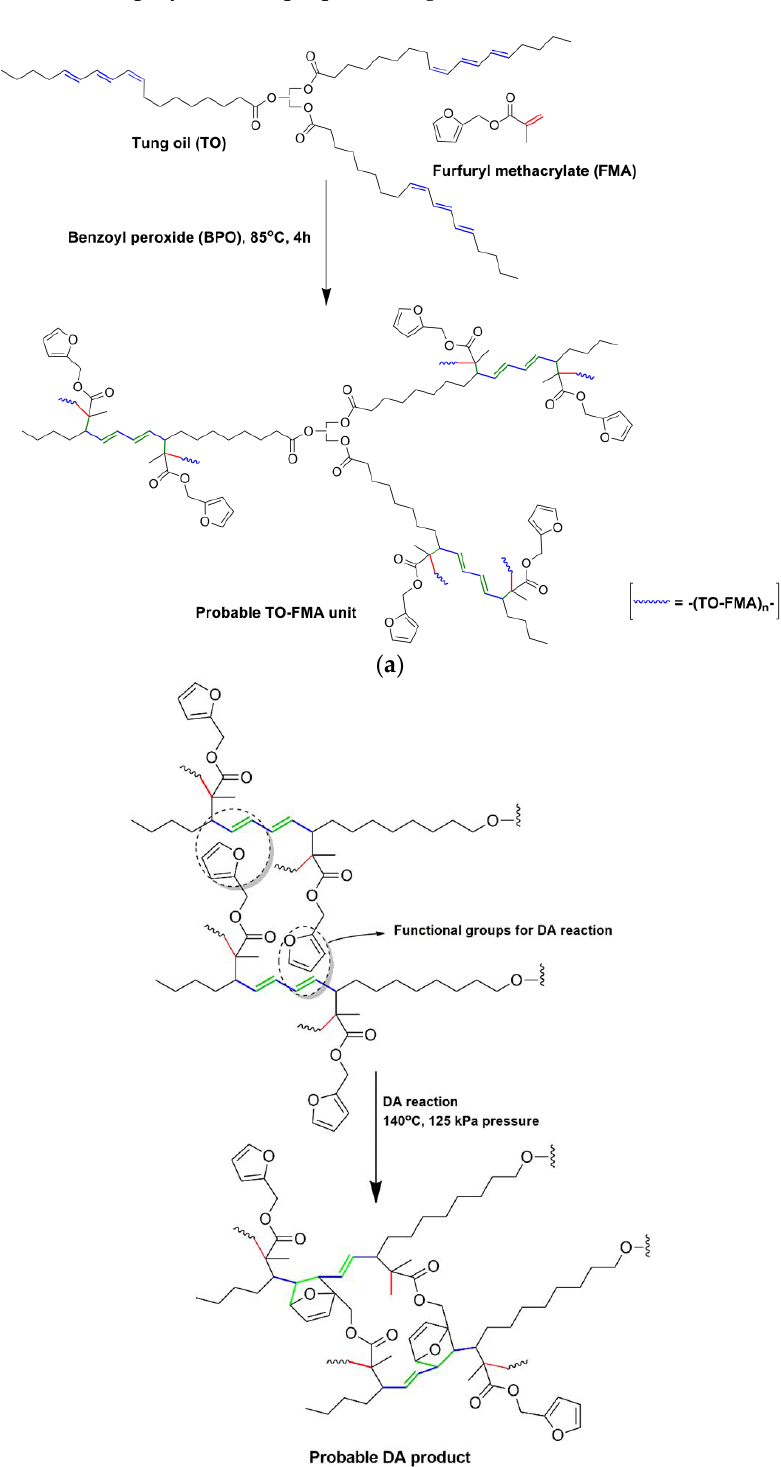
Figure 11. ( a ) Probable reaction scheme for free radical polymerisation. ( b ) Probable reaction scheme for Diels-Alder (DA) reaction.